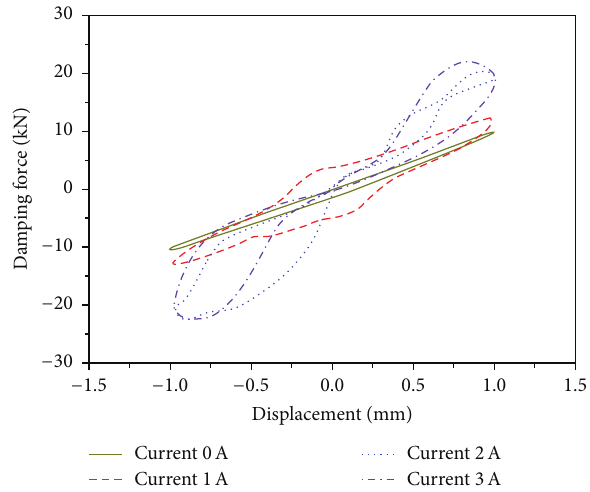
Figure 6: Block-up phenomenon in high loaded MR mount.